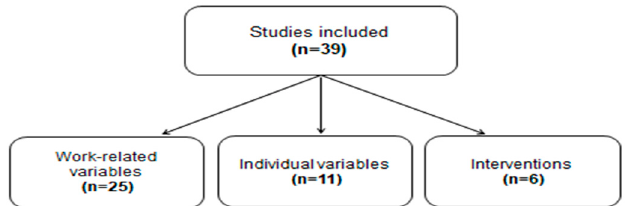
Figure 2. Flowchart of the allocation into the three categories: “Work-related Variables”, “Individual Variables”,